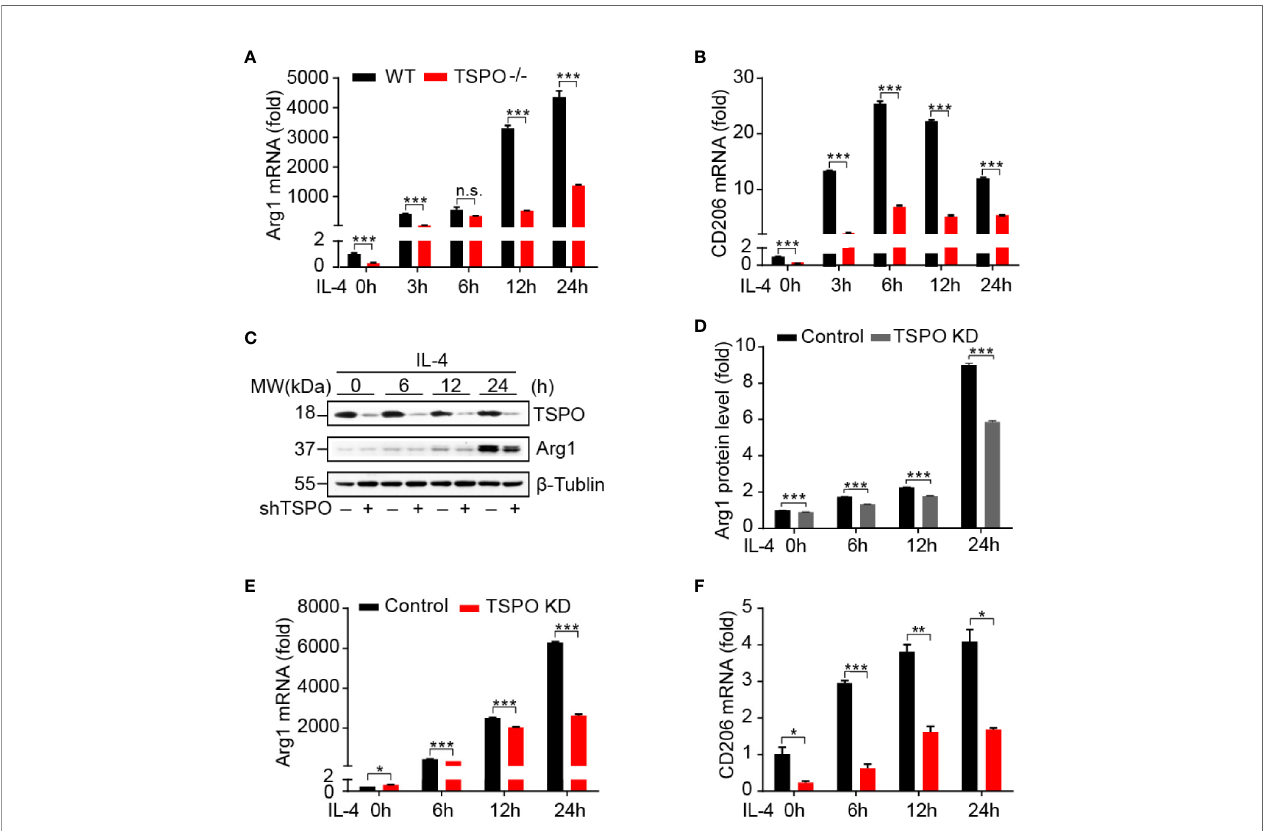
FIGURE 2 | TSPO de fi ciency inhibits IL-4 – induced microglial activation. WT and TSPO-knockout microglial cells were stimulated with IL-4 (1 µg/ml) for the indicated amounts of time. (A, B) RT-qPCR determined mRNA changes in the M2 markers Arg1 and CD206. The same conditions were applied to shvector and shTSPO BV2